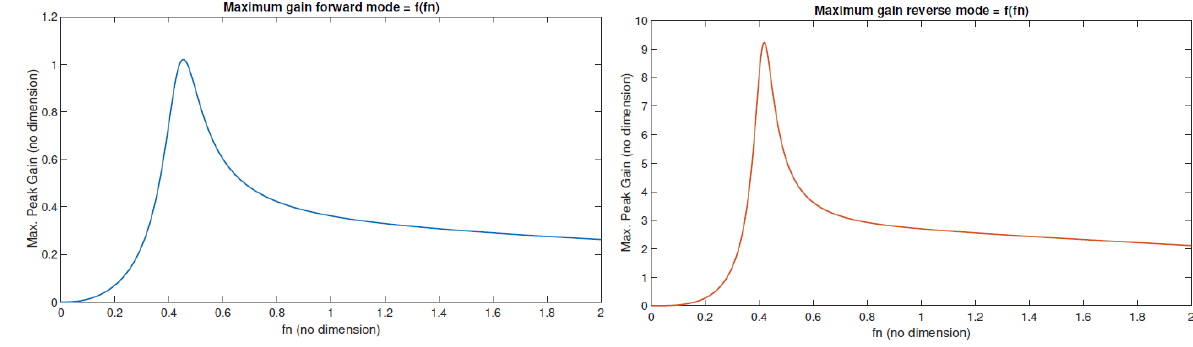
Figure 11. Forward and reverse gain from the selected values of Q e , k , and g